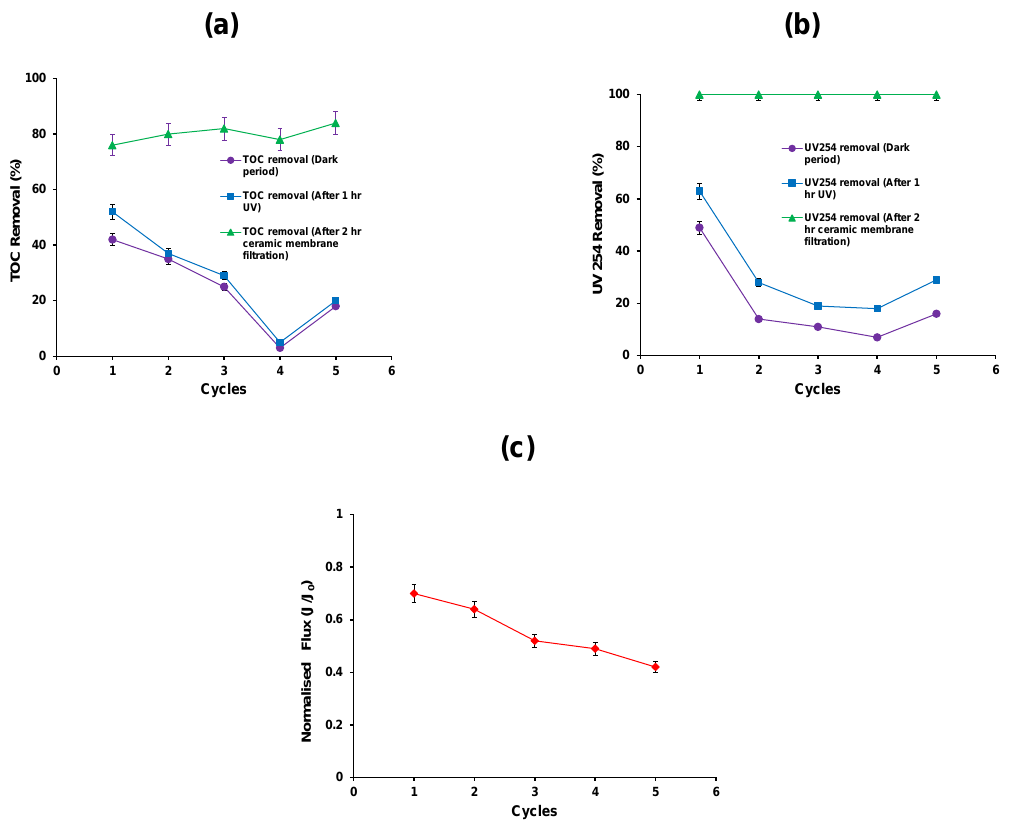
Figure 5. ( a ) TOC removal efficiency; ( b ) reduction in UV absorbance ( c ) Normalised flux of the photocatalytic—ceramic membrane integrated system (HA concentration: 20 mg/L, TiO 2 concentration: 0.5 g/L, TMP: 100 kPa, CFV: 0.4 m/s; pH: 7.5; UV intensity: 3.4 mW/cm 2 ).